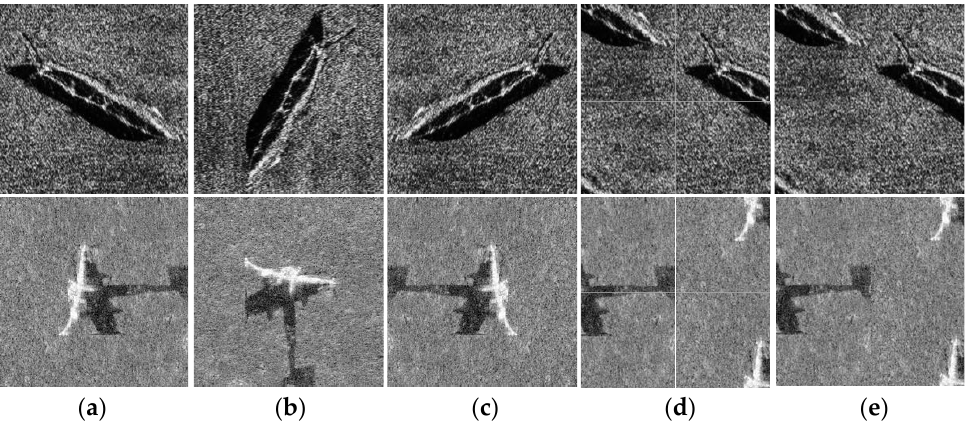
Figure 8. Sample examples of basic data enhancement methods: ( a ) original image sample; ( b ) flip- ping sample; ( c ) rotating sample; ( d ) cropping samples; ( e ) cropping and stitching